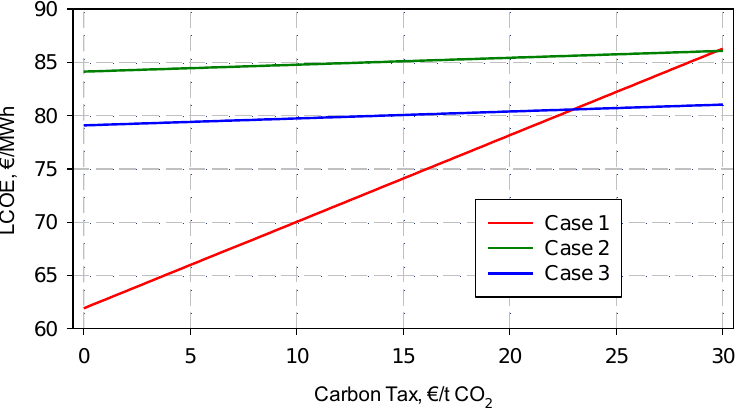
Figure 2. E ff ect of the change in carbon tax on Figure 2. Effect of the change in carbon tax on LCOE.